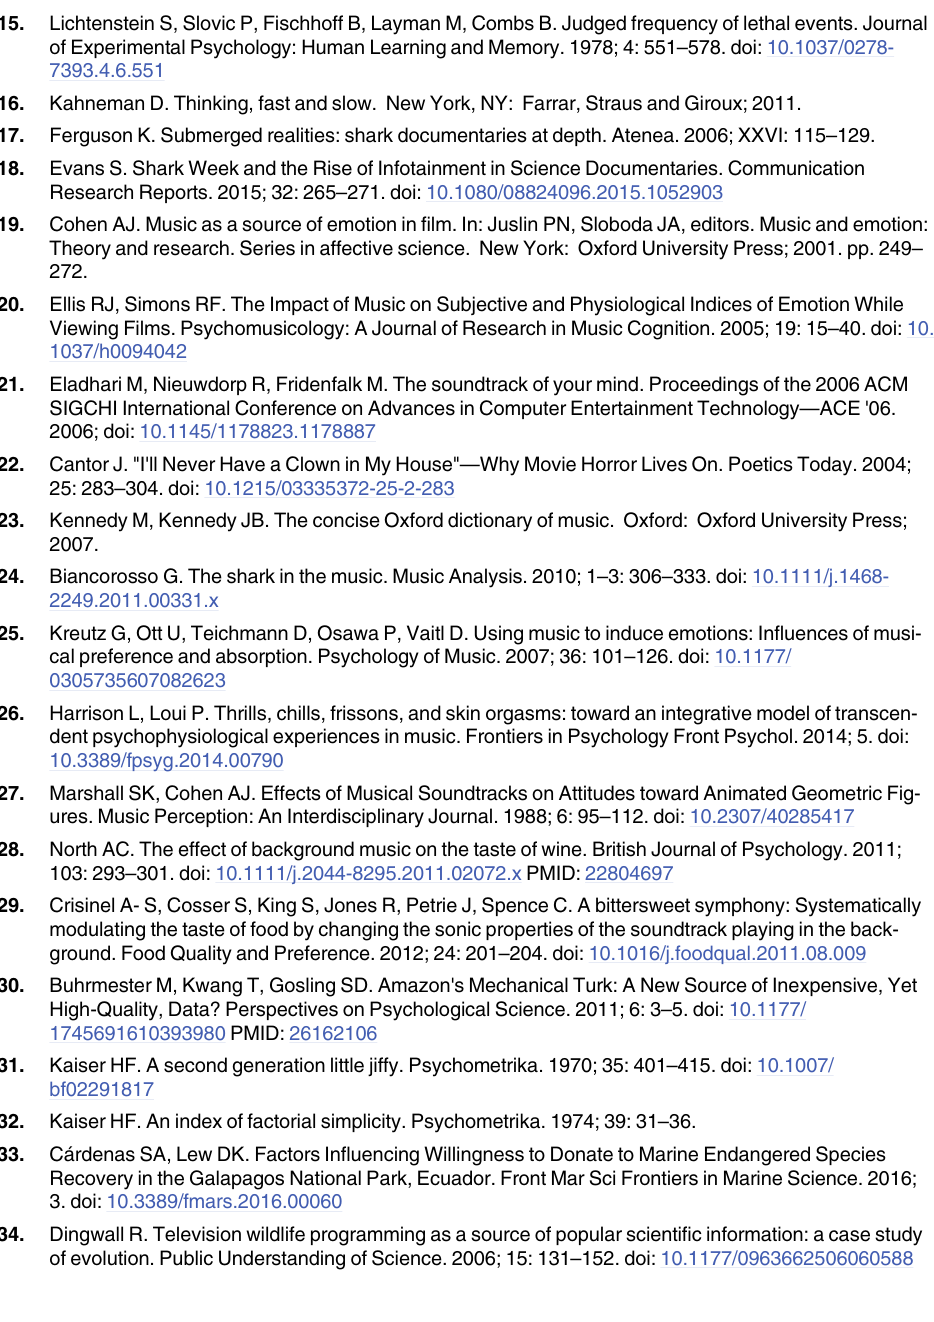
PLOS ONE | DOI:10.1371/journal.pone.0159279 August 3,